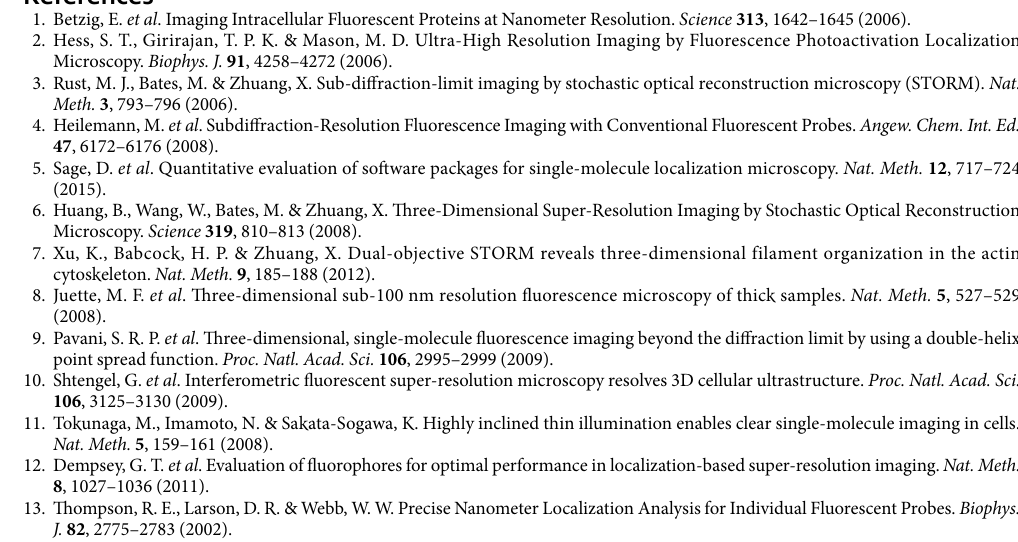
8 Scientific RepoRts | 7: 4077 | DOI:10.1038/s41598-017-04450-w